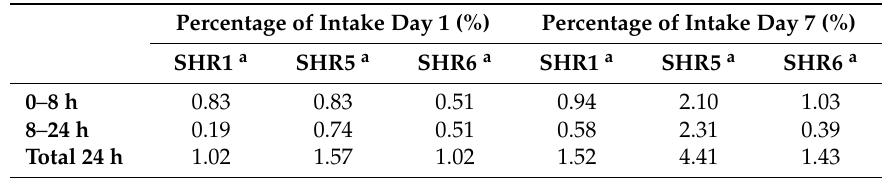
Table 5. Percentage of intake of different grape pomace extracts excreted in urine at day 1 and day 7, 0–8 h, 8–24 h and 0–24 h after